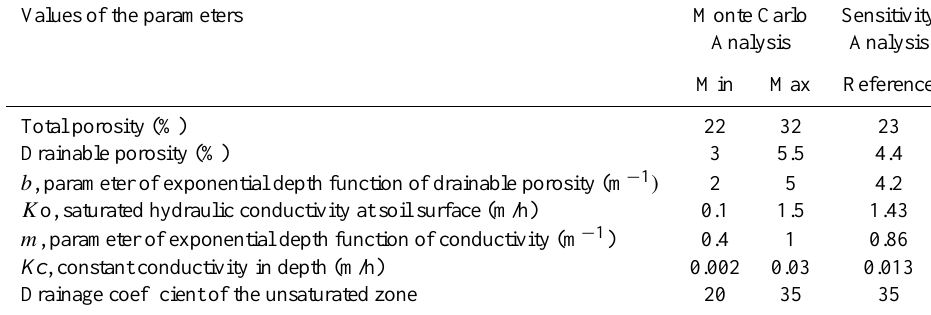
Figure 3. Variations of the water table depth: A) Temporal distribution of the water table depth in the six wells, calculated on five water years (1998 to 2002); B) Reactivity of the water table depth versus rainfall amount, calculated for all the rainfall events of five wet seasons (January to March, from 1998 to 2002 ) (N=88).